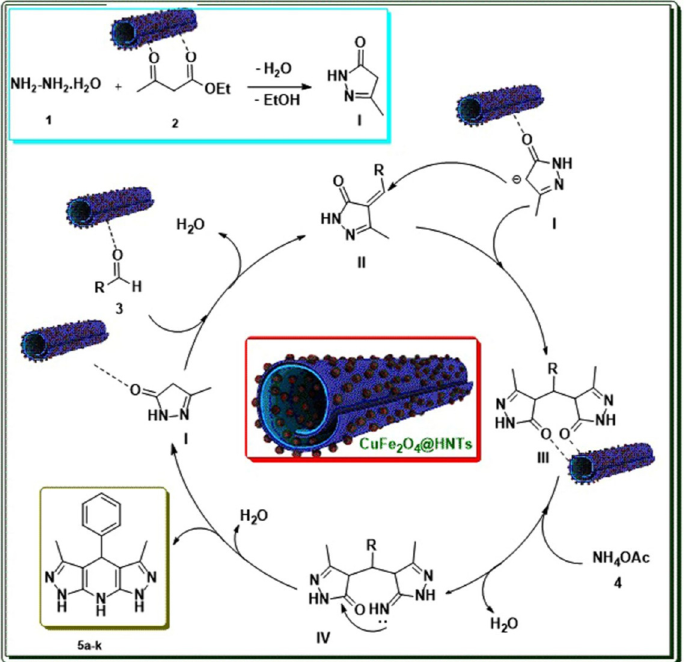
Figure 10. Proposed mechanism for the synthesis of pyrazolopyridine derivatives in the presence of CuFe 2 O 4 @HNTs. Reproduced with permission from ref. [99].